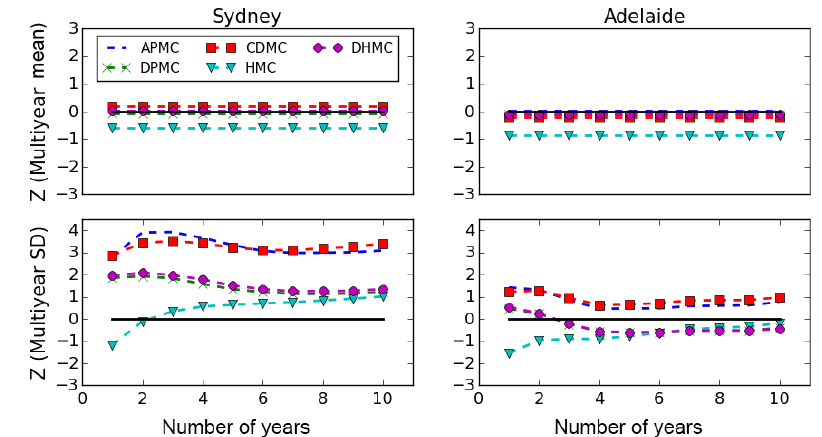
Figure 11. Comparison of the mean and SD of multiyear number of wet days for the five MC models.